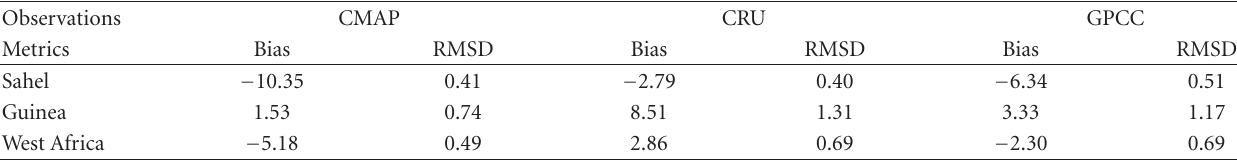
Table 2: Mean bias and spatial root mean square di ff erence (RMSD) at di ff erent subdomains considered in Figure 1(b) for CMAP, CRU, and GPCC rainfall with respect to GPCP. Observational datasets (CMAP, CRU, and GPCC) are interpolated to GPCP grid. Bias is expressed as percentage of GPCP value while RMSD as